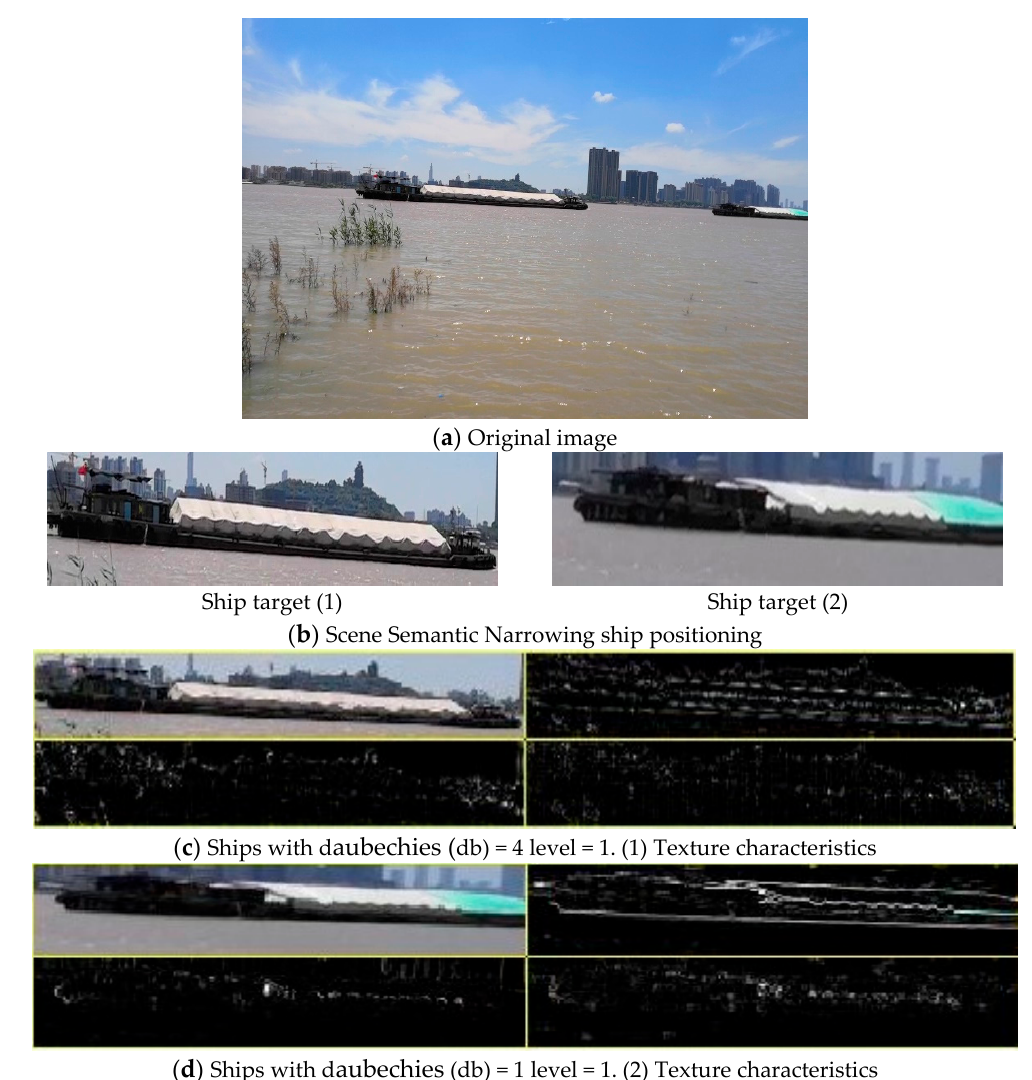
Figure 8. Video image ship texture features.